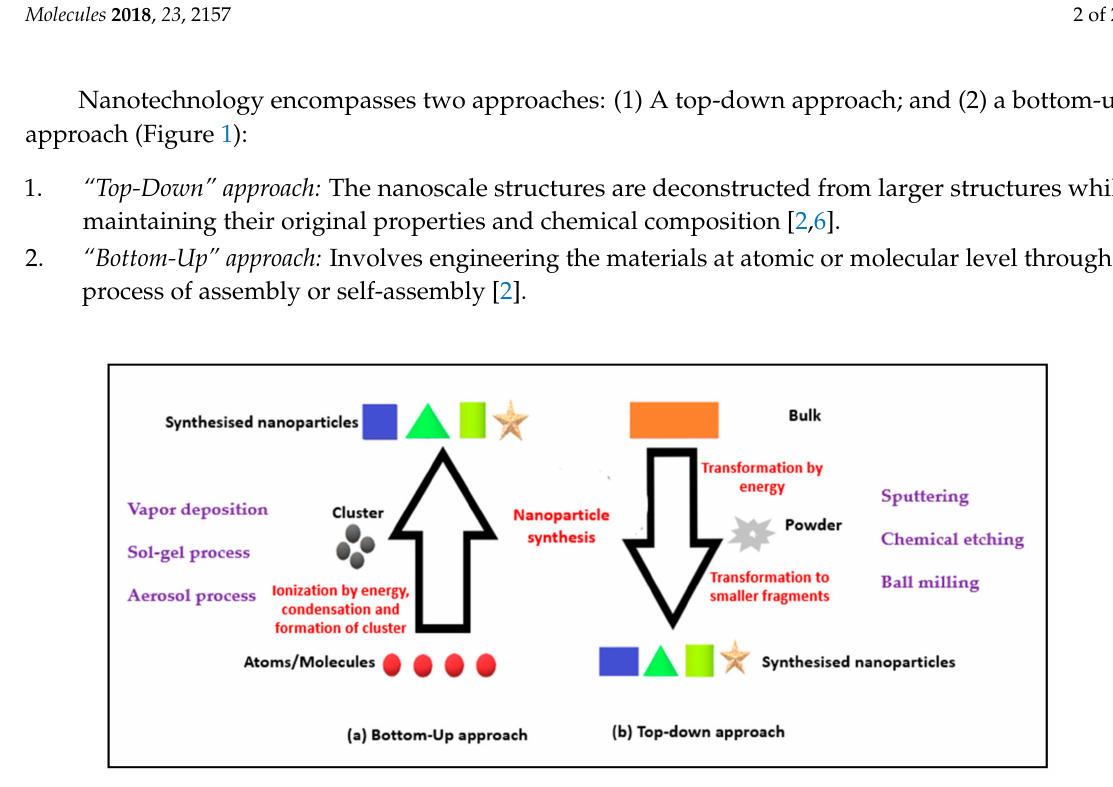
Figure 1. Schematic representation of ( a ) bottom-up; and ( b ) top-down